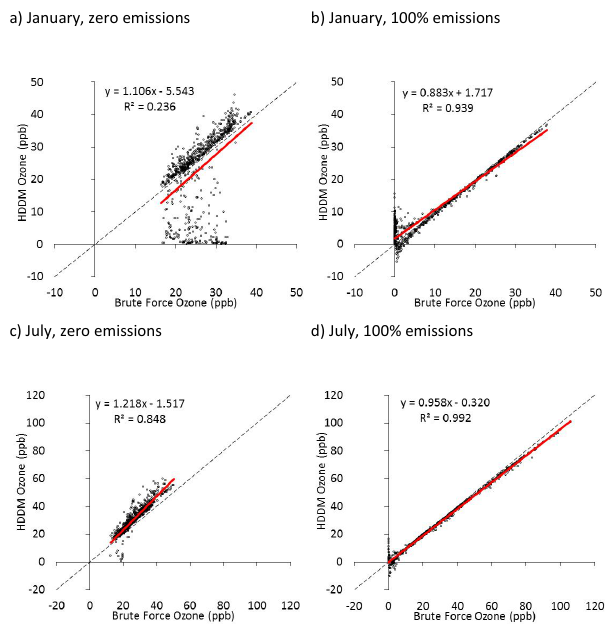
Fig. 6. Hourly ozone at the urban Dallas location predicted by HDDM with Eq. (3) vs. brute force CAMx simulations for (a) zero anthropogenic NO x and VOC emissions in January, (b) 100% an- thropogenic NO x and VOC emissions in January, (c) zero anthro- pogenic NO x and VOC emissions in July, and (d) 100% anthro- pogenic NO x and VOC emissions in July. Dashed lines show 1 : 1 agreement and solid red lines show least-squares